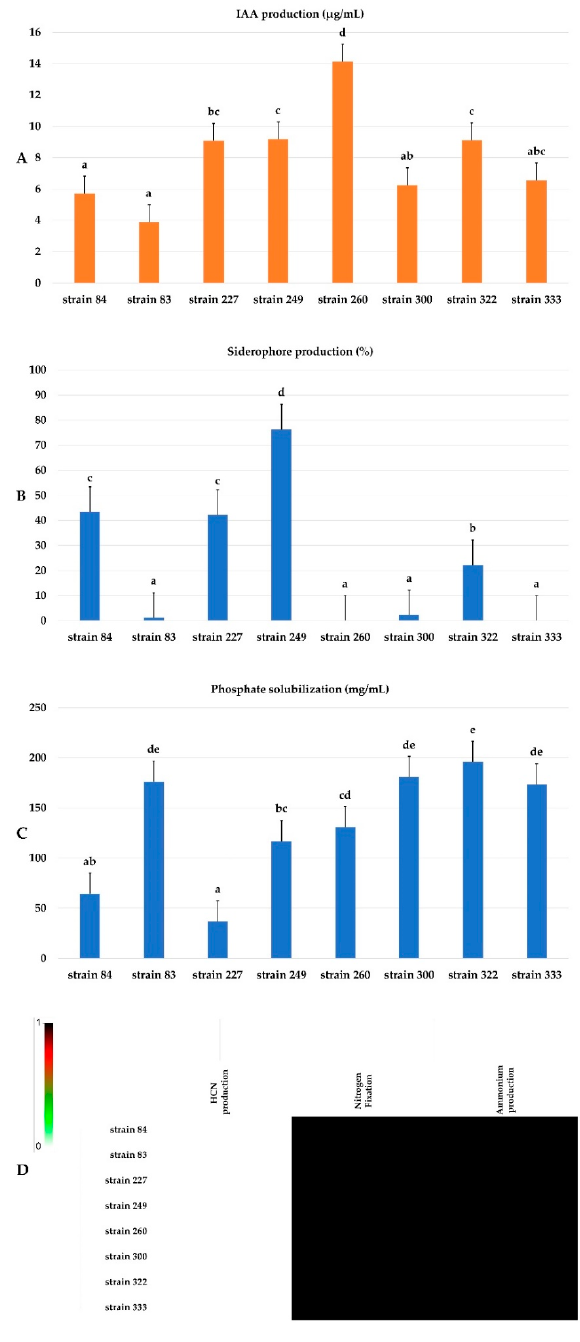
Figure 12. PGP activities of the different bacterial strains. ( A ) Production of IAA ( μ g/mL), ( B ) Production of siderophores (%), and ( C ) Solubilization of phosphates (mg/mL). The data present the means ± the standard error. Different letters between bars in each group indicate a significant difference at ( p < 0.05) determined by ANOVA with the comparison of means using Tukey’s HSD. ( D ) HCN production, nitrogen fixation, and NH3